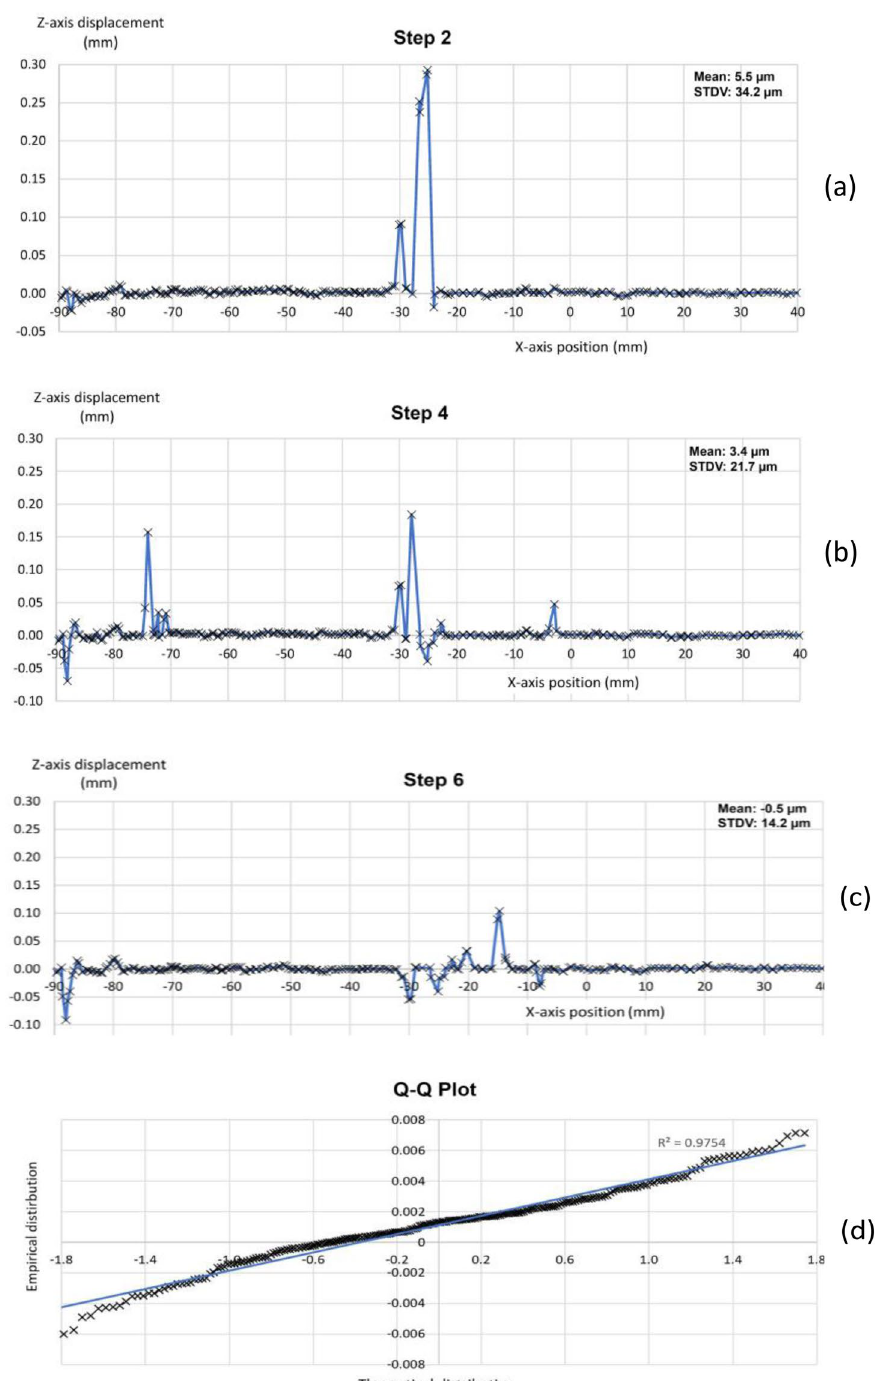
Figure 5. Noise baseline computed from DIC processing. Sample of initial steps not affected by the wheel load: ( a ) Step 2; ( b ) Step 4; ( c ) Step 6; ( d ) the Q-Q plot for step